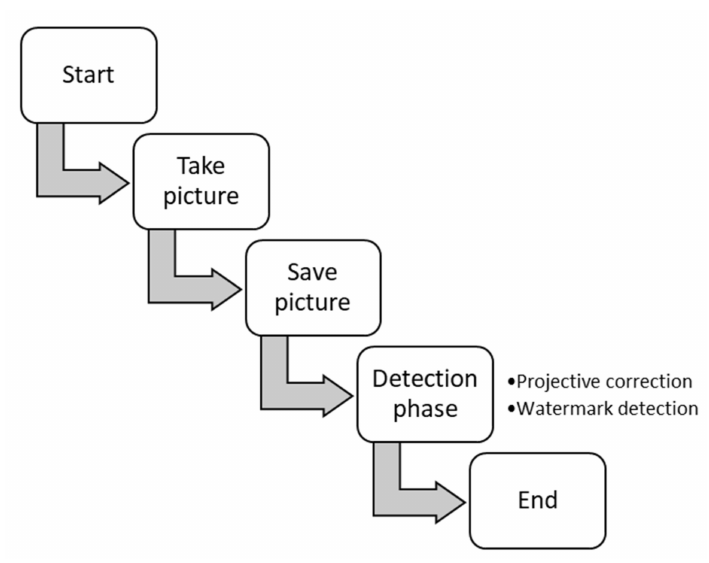
Figure 6. Flow process of watermark detection in the proposed